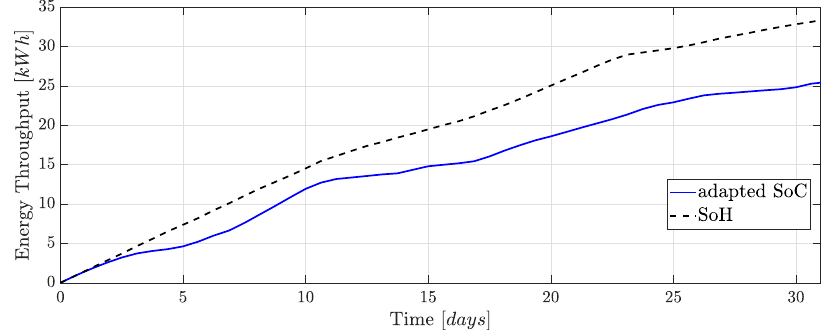
Figure 29. Energy Throughput: Case